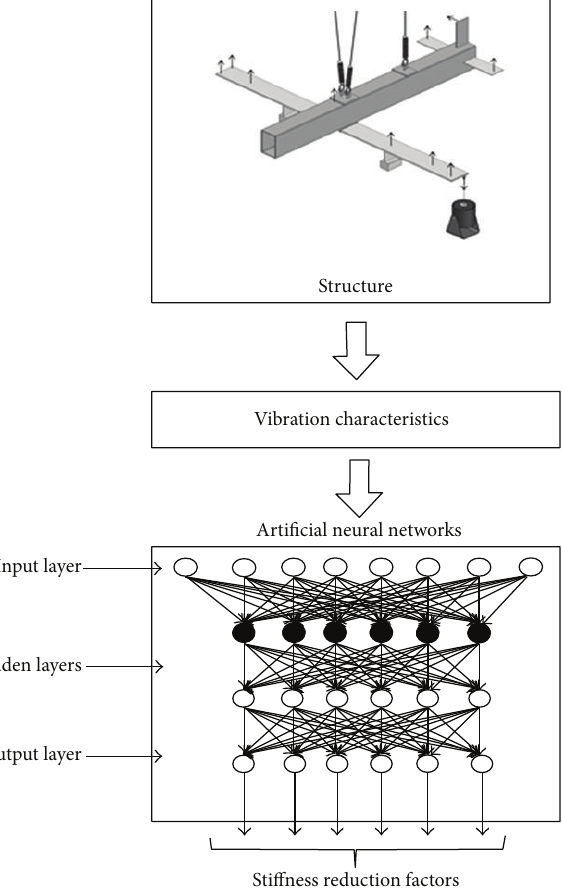
Figure 2: Damage assessment with artificial neural